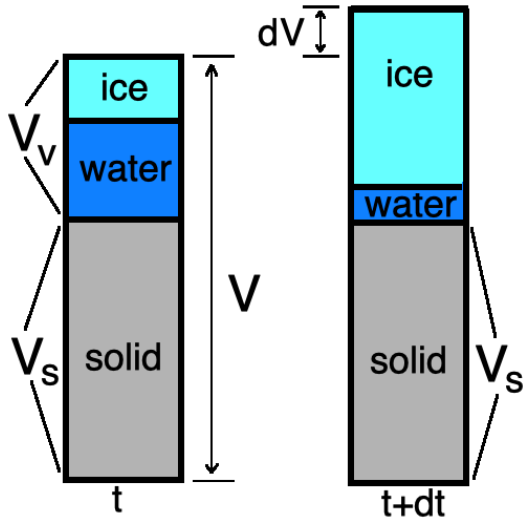
Figure 2. Representation of porous media volume changing. V is the volume at the time t and ( V + dV ) is a volume at time t + dt